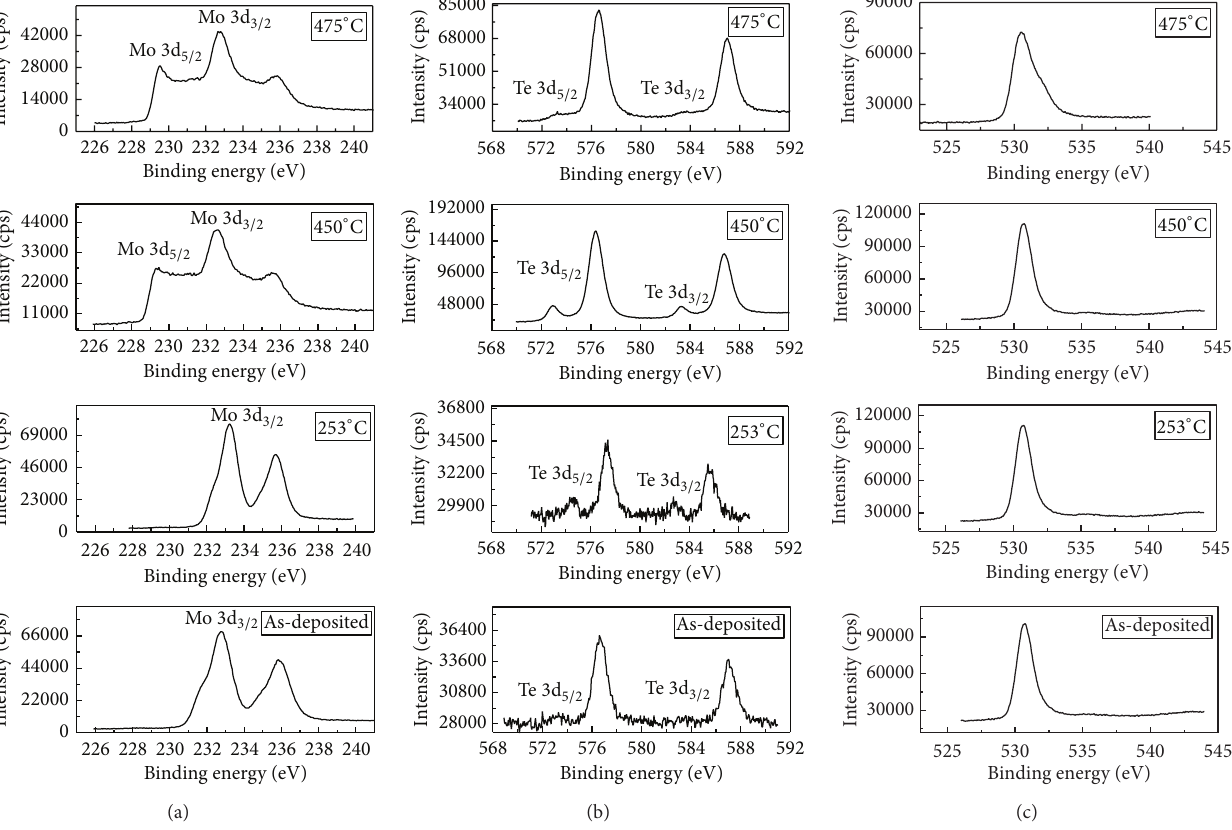
Figure 5: XPS spectra of (a) Mo 3d, (b) Te 3d, and (c) O 1s for Mo-Te thin films annealed at different